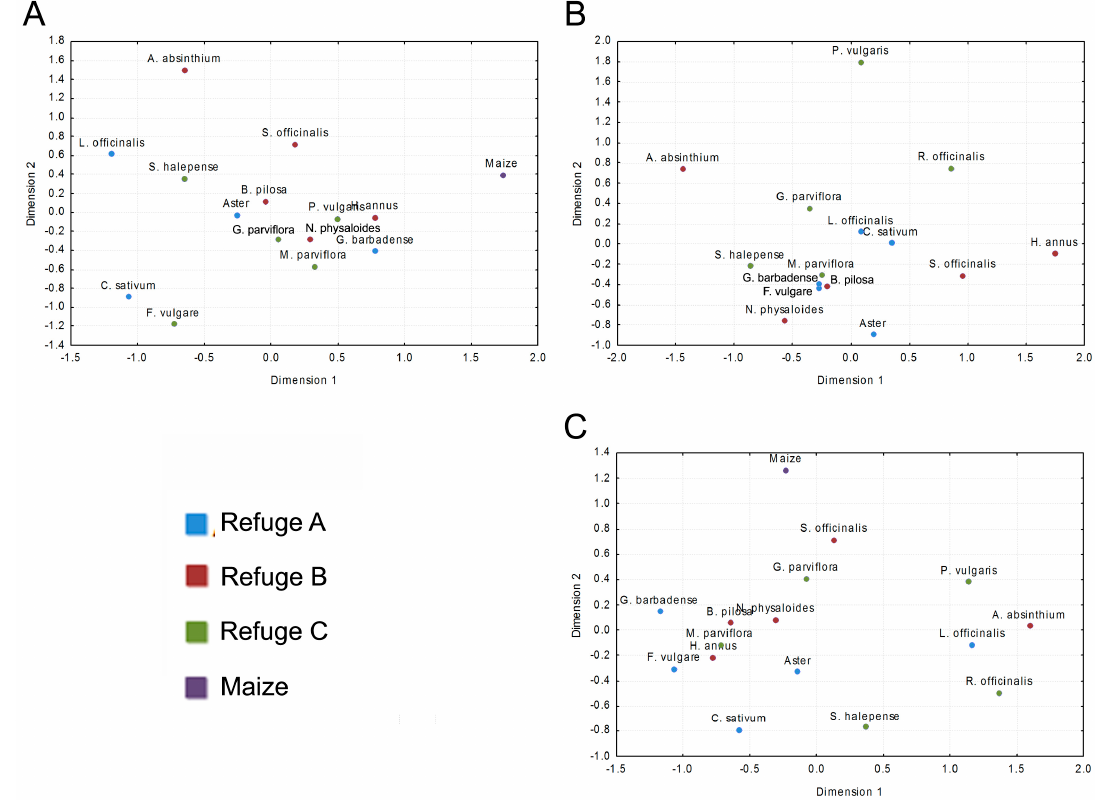
Figure 2. Multidimensional scale (MDS) plot from the Jaccard index similarities matrix amongst insect compositions occurring in every plant species from each refuge, for each functional group: ( A ) herbivores, ( B ) parasitoids, and ( C ) predators.